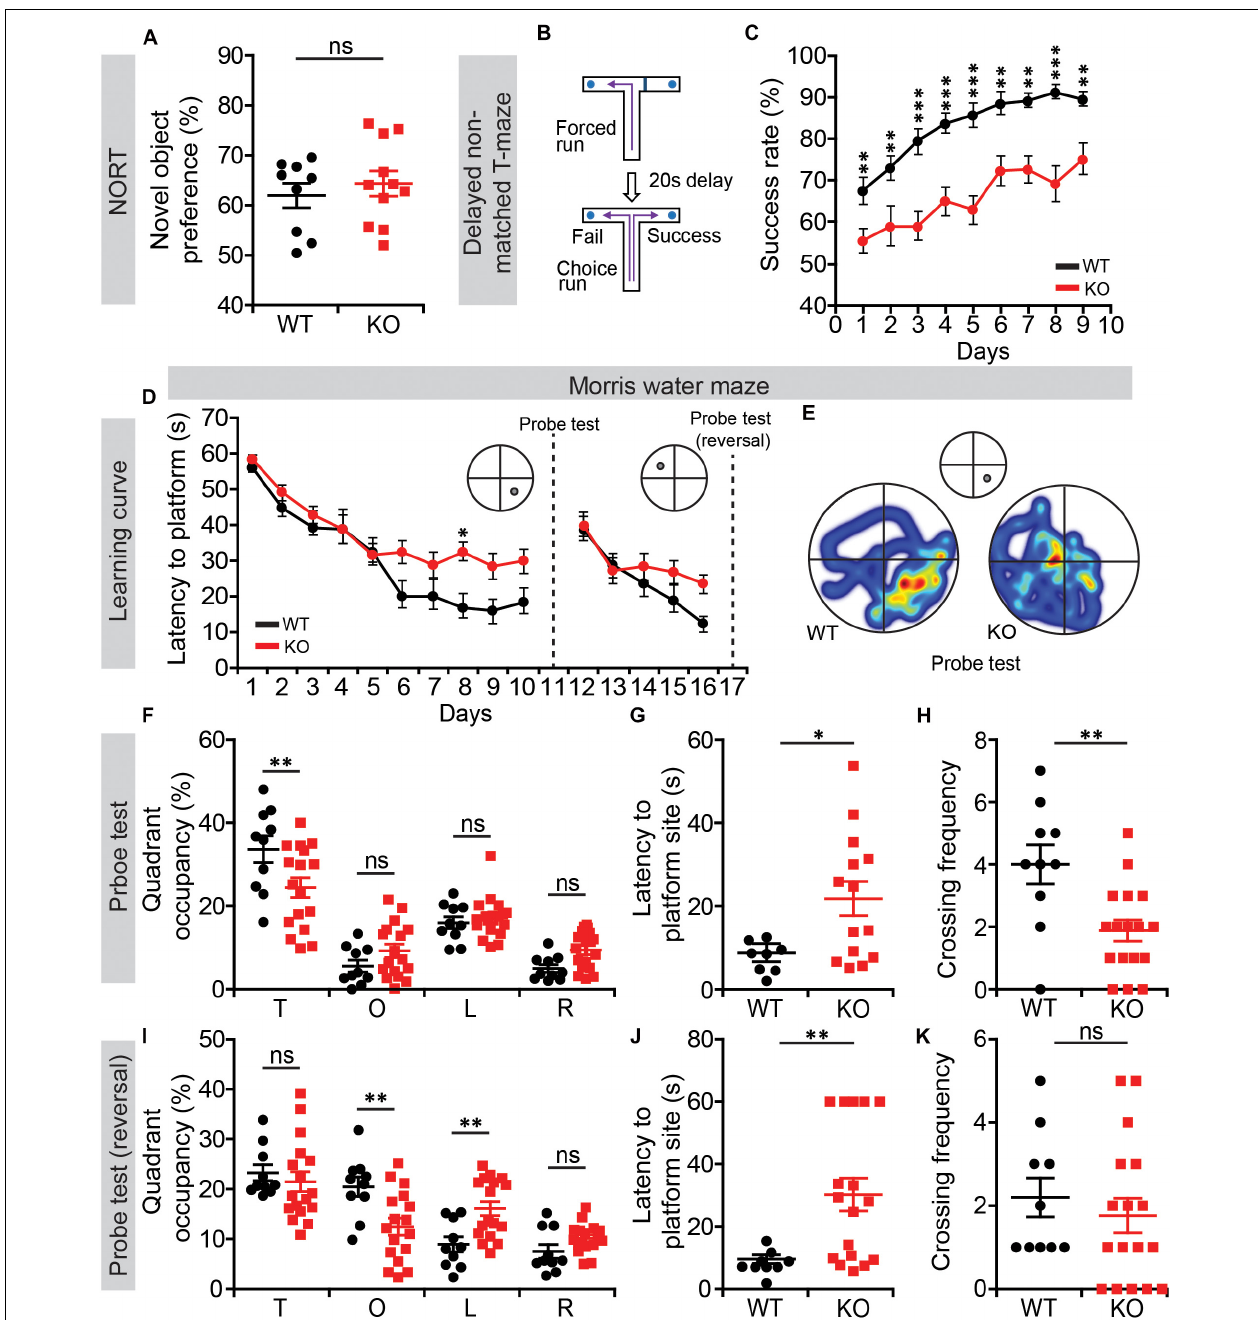
FIGURE 4 | Suppressed working and contextual memory in Lrrc4c − / − mice. (A) Normal novel-object recognition in Lrrc4c − / − mice (2–5 months; male). n = 9 (WT), n = 11 (KO), ns, not significant, Student’s t -test [ t ( 18 ) = 0.6718; p = 0.5102]. (B,C) Suppressed working memory in Lrrc4c − / − mice (2–5 months; male) in the delayed non-match choice T-maze test. n = 29 (WT), n = 22 (KO), ∗∗ p < 0.01, ∗∗∗ p < 0.001, two-way repeated-measures ANOVA with Holm-Sidak multiple comparison test [ (C) interaction, F ( 8 , 392 ) = 1.01, p = 0.4276; genotype, F ( 1 , 49 ) = 44.74, p < 0.001; time, F ( 8 , 392 ) = 15.88, p < 0.001; day 1, p = 0.0059, day 2, p = 0.0033, day 3, p < 0.001, day 4, p = 0.0001, day 5, p < 0.001, day 6, p = 0.0010, day 7, p = 0.0008, day 8, p < 0.001, day 9, p = 0.0032]. (D–K) Suppressed spatial learning and memory in Lrrc4c − / − mice (2–5 months; male) in the Morris water-maze test, as shown by performance in initial learning (D) , initial probe (E–H) , reversal learning (D) , and reversal probe (I–K) phases. n = 10 (WT), n = 17 (KO), ∗ p < 0.05, ∗∗ p < 0.01, ns, not significant, two-way repeated-measures ANOVA with Holm-Sidak multiple comparison test, Student’s t -test [ (D) interaction, F ( 9 , 225 ) = 1.65, p = 0.1025; genotype, F ( 1 , 25 ) = 6.576, p = 0.0167; time, F ( 9 , 225 ) = 27.25, p < 0.001; day 8, p = 0.0215; (F) interaction, F ( 3 , 75 ) = 4.298, p = 0.0075; genotype, F ( 1 , 25 ) = 1.735, p = 0.1997; time, F ( 3 , 75 ) = 45.99, p < 0.001; target, p = 0.0028; (G) t ( 20 ) = 2.525; p = 0.0201; (H) t ( 25 ) = 3.227; p = 0.0035; (I) interaction, F ( 3 , 75 ) = 5.631, p = 0.0016; genotype, F ( 1 , 25 ) = 0.7606, p = 0.3914; time, F ( 3 , 75 ) = 18.15, p < 0.001; opposite, p = 0.0040 left, p = 0.0091; (J) t ( 24 ) = 2.966; p = 0.0067; (K) t ( 25 ) = 0.6689; p =